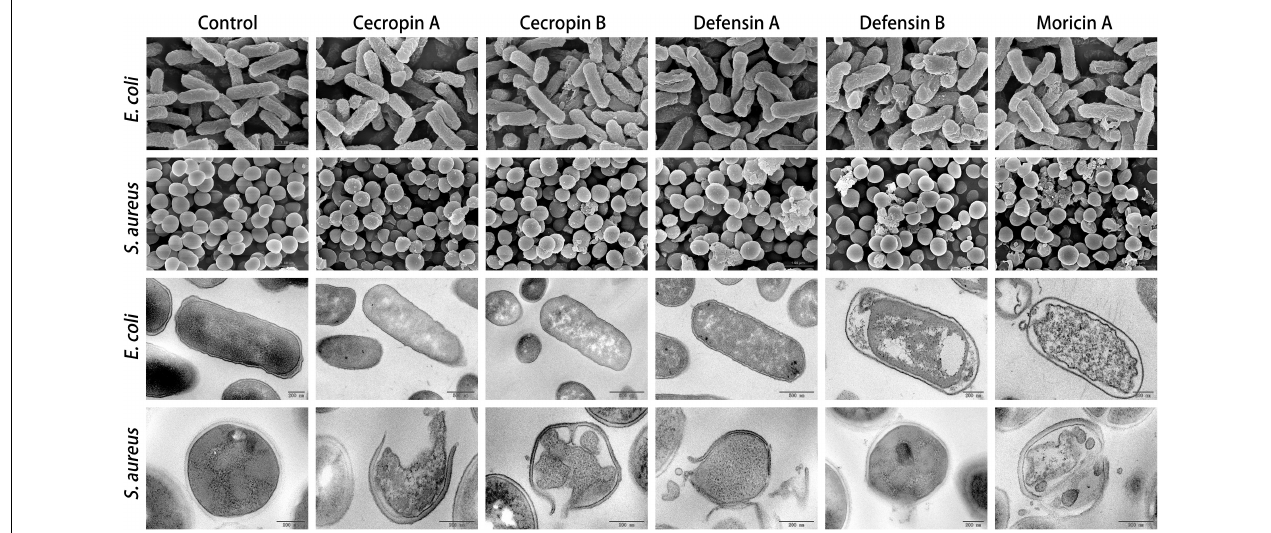
FIGURE 5 | Electron microscopic analysis of bacteria treated with synthetic antimicrobial peptides (AMPs). Representative images of both scanning electron microscopy (SEM; upper panels) and transmission electron microscopy (TEM; lower panels) showed significant changes on cell morphology induced by AMPs at 4 × of corresponding minimum inhibitory concentration (MIC) value, compared with the intact smooth surfaces of the untreated control group (left panel). The TEM assay further displayed marked decreases in cell densities that resulted from peptide intervention. These findings suggest membrane permeabilization mechanism being involved in bactericidal activities of the synthesized butterfly